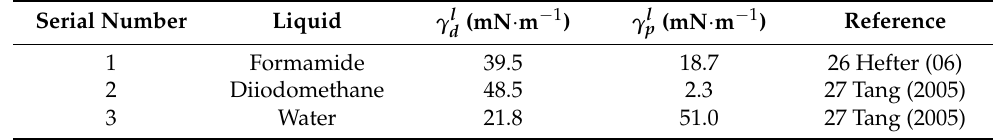
Table 2. Literature data on contact angle probe liquid